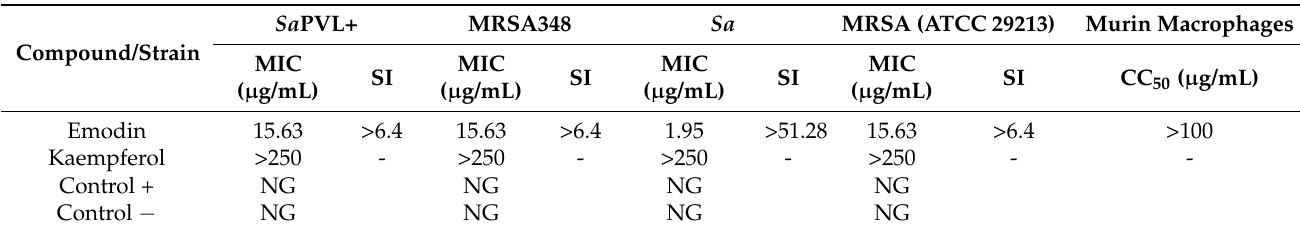
Control + NG Control - Control +: strain and LB medium; control -: strain and 2% DMSO; NG: normal growth. BMC of emodin >250 µg/mL. MIC: minimum inhibitory concentration. CC 50 : cytotoxic concentration that reduces viability of murine macrophages by 50%. SI: CC 50 /MIC.